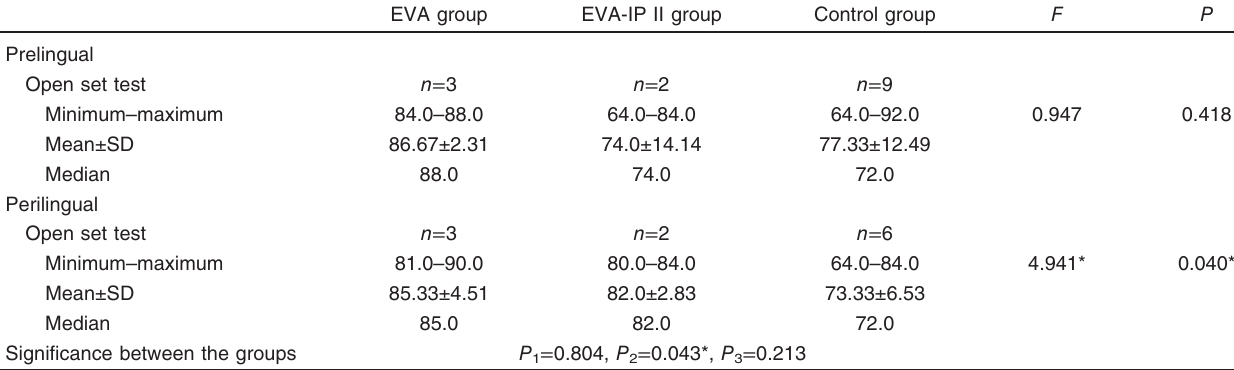
Table 5 Comparison between groups according to open-set speech discrimination test scores (%)